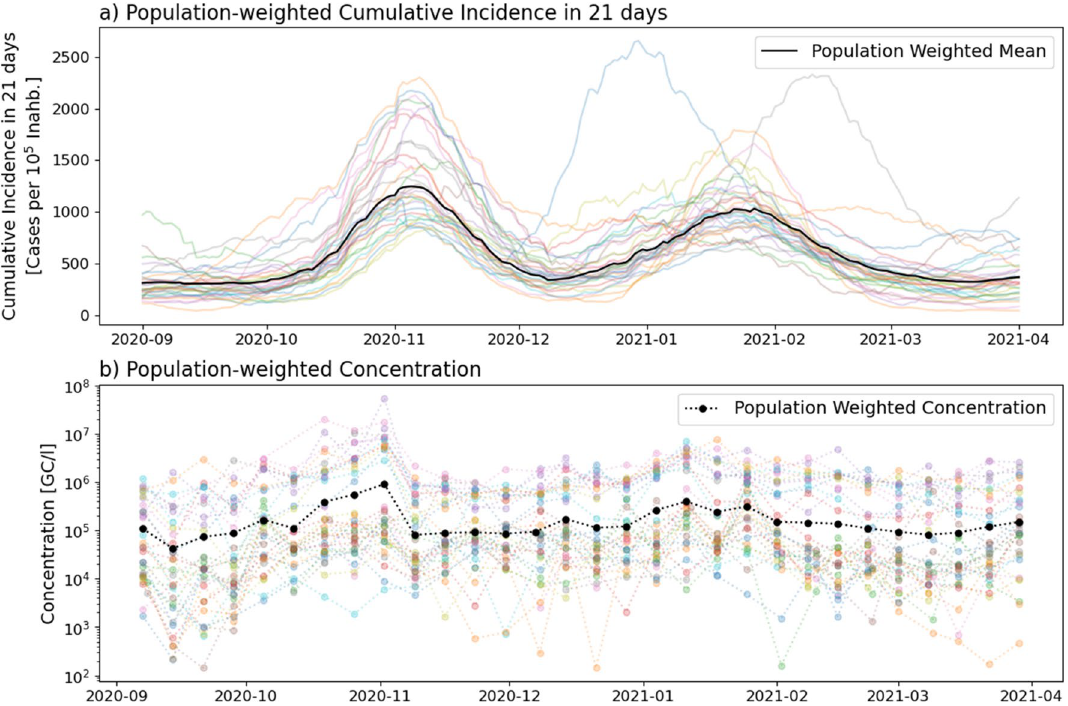
Figure 1. Population-averaged 21-day cumulative incidence [cases per 10 5 inhabitants] and concentration [GC/l]. Transparent coloured lines show the data corresponding to each BHA and WWTP, and the black lines show the population-weighted